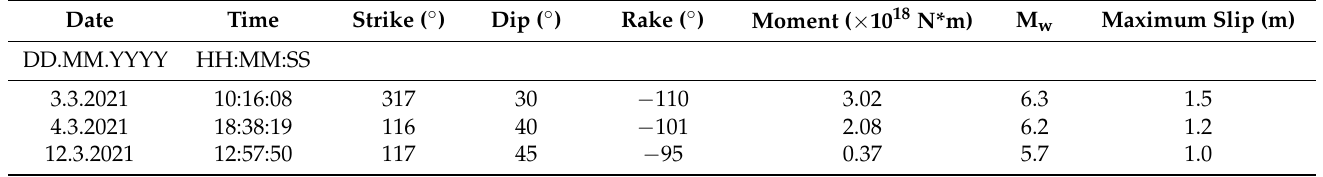
Table 5. Seismic source solutions determined from InSAR analysis for the three strong earthquakes of March 2021.